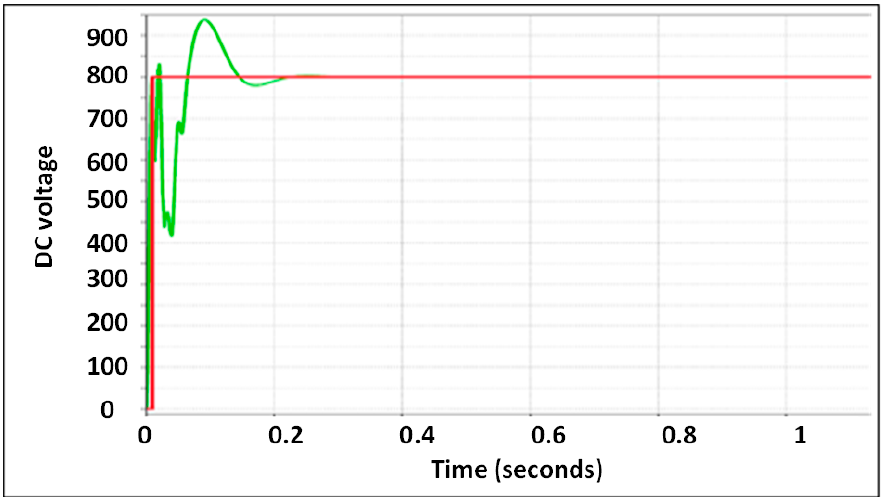
Figure 13. The voltage control response for the DC link.